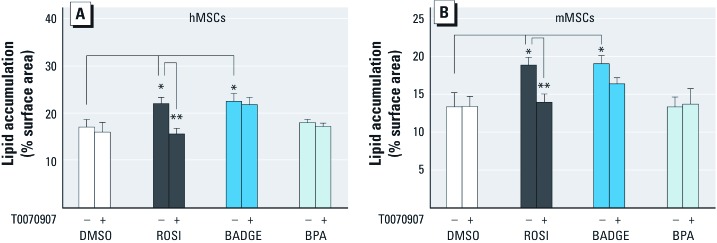
Effect of the PPARγ antagonist T0070907 in BADGE- or BPA-induced adipogenic abilities of MSCs. Adipogenesis was induced in hMSCs (A) or mMSCs (B) by the addition of an adipogenic cocktail for 14 days with DMSO, 500 nM ROSI, 100 nM BADGE, or 100 nM BPA in the presence of DMSO or 100 nM T0070907 (PPARγ antagonist). All data are expressed as mean ± SE lipid accumulation in six replicates. *p < 0.05, and **p < 0.01 relative to vehicle (DMSO) controls.